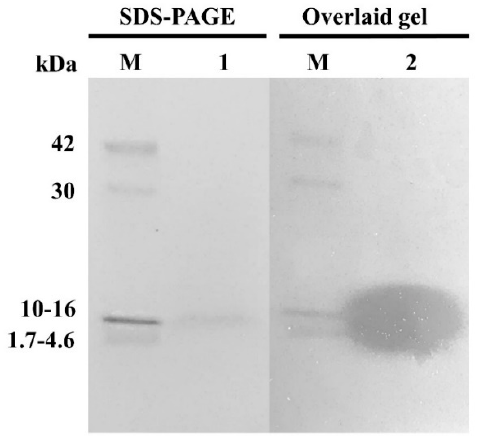
Figure 4. SDS-PAGE of the partially purified AMPs produced by E. faecium OV3-6. Lane M: low molecular weight protein marker (MW 1700–42,000 Da); Lane 1: SDS-PAGE band; Lane 2: inhibition zone of the SDS-PAGE band overlaid with tested strain S. aureus CIP 76.25 in BHI agar.